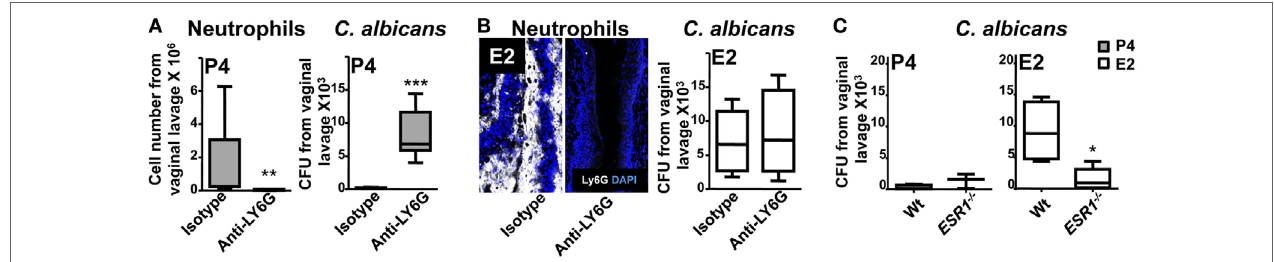
FigUre 10 | Hormone regulation of neutrophil killing activity. Bilaterally ovariectomized mice received hormone-treatment subcutaneously and rat anti-mouse LY6G (1A8) or isotype control antibody intravenously 24 h prior to Candida albicans inoculation to deplete the neutrophils. (a) Progesterone and (B) estradiol treated mice 6 h after the infection. Number of neutrophils and fungal burden (CFU) in the vaginal lavage after the infection ( n = 6–8). (c) Fungal burden (CFU) in the vaginal lavage of progesterone or estradiol-treated ESR1 − / − and Wt mice challenged with C. albicans . Data are expressed as box and whiskers 10–90 percentile ( n = 5). * p < 0.05, ** p < 0.01, and *** p < 0.001 Mann–Whitney. Abbreviations: CFU, colony forming unit. E2, estradiol; P4, progesterone.